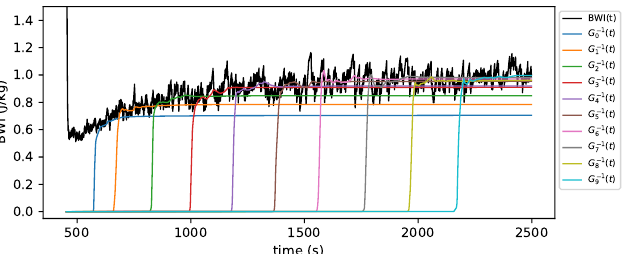
Figure 15. Time evolution of the bond ball mill work index (BWI) measured in the mill with material from both sources. The evolution of the backtracked (inverse) grindability at 10 individual blocks at the left source is also shown. The variations in power draw and hardness with a 55 s time period match the frequency of the truck hauling from the left